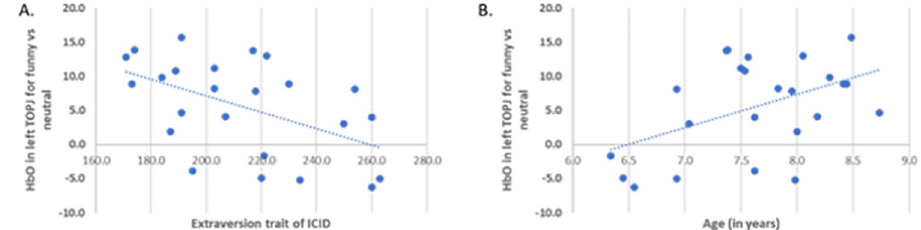
Fig 3. Correlation analysis with HbO and behavioral indexes. (A) HbO in left TOPJ negatively correlated with extraversion (B) HbO in left TOPJ positively correlated with age.